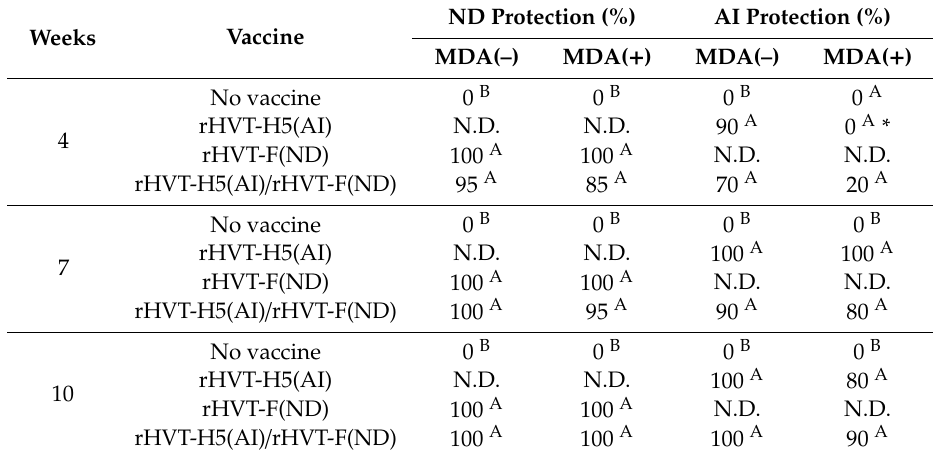
Table 2. Clinical protection against challenges with vNDV and H5-HPAIV strains in LBL layer